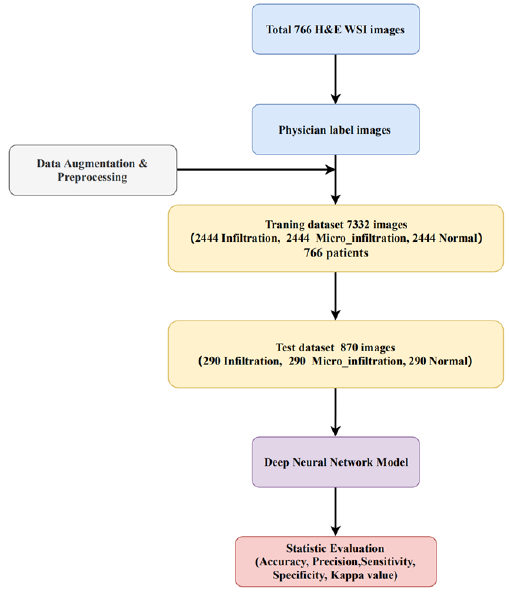
Figure 2. Overall experimental data preparation and